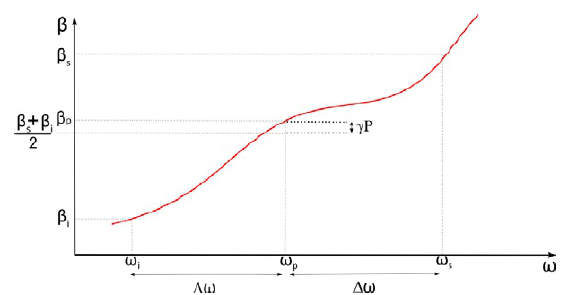
Fig. 6. Phase-matching for a large signal and idler detuning. When β 4 p > 0 and β 2 p < 0 there is, in addition to the solution in the vicin- ity of the pump frequency, ω , a second pair of signal and idler p frequencies which are phase-matched with the pump frequency.